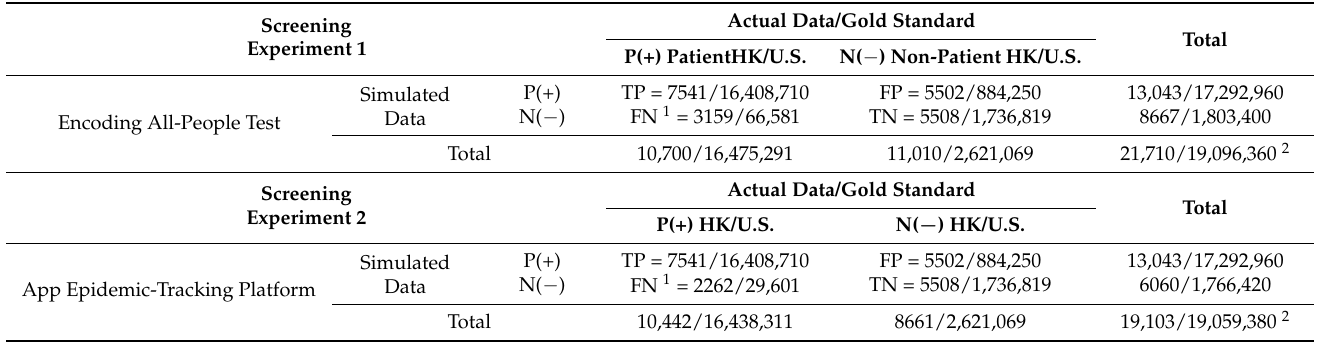
Table 9. Confusion matrix of two experiments.